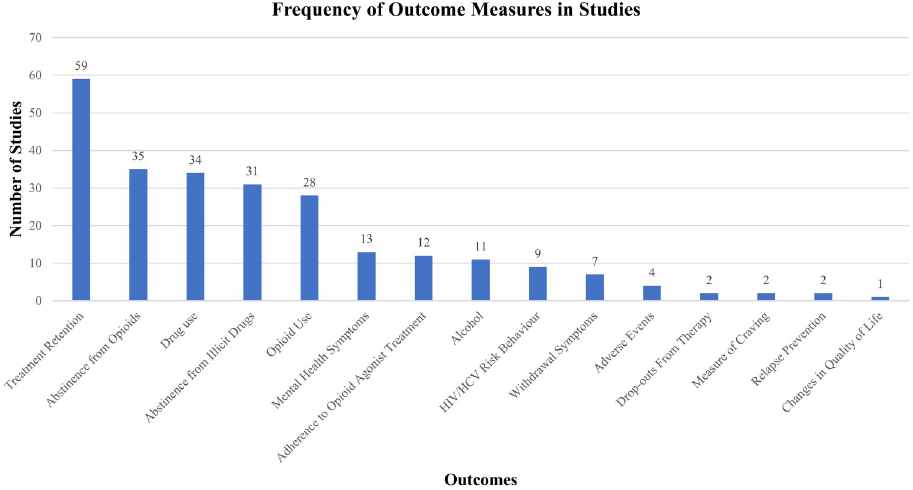
Fig 3. Outcomes reported in included studies. The extent to which the outcomes of a priori interest were reported for each eligible treatment arm across the set of included studies are presented.